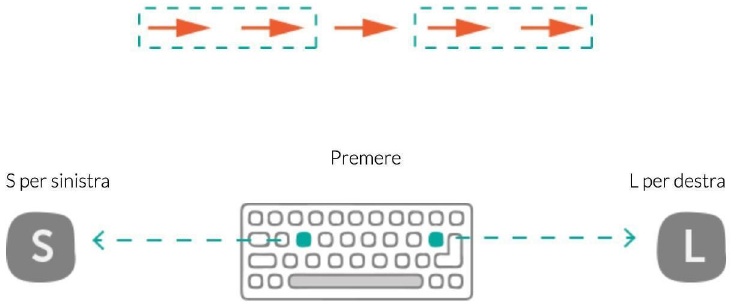
Figure 2. Flanker task, exemplification of the 2nd block, peripheral congruent condition.